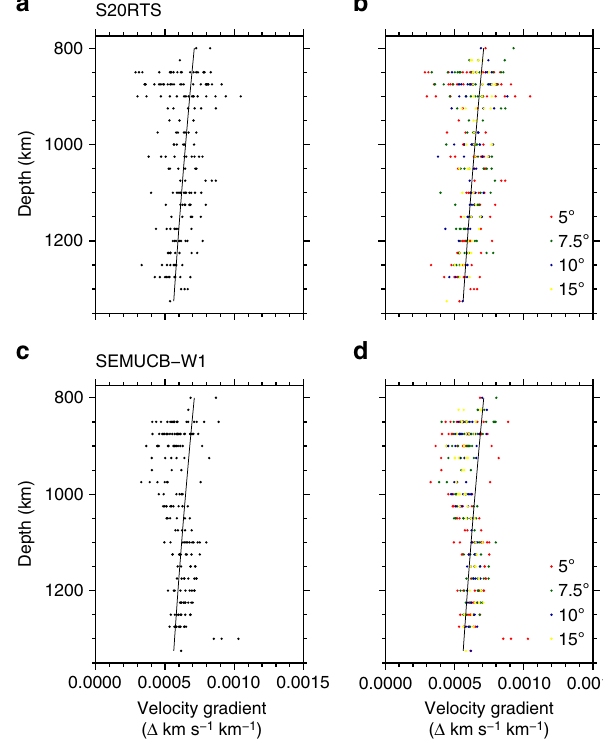
Fig. 8 Velocity gradients at the estimated depths of re fl ectors for S20RTS and SEMUCB-W1. a Combined bins, S20RTS 48 . b All bin sizes, S20RTS. c Combined bins, SEMUCB-W1 49 . d All bin sizes, SEMUCB-W1. Circles represented observed re fl ectors. Colours correspond to bin sizes as indicated in the key in b , d . Lines correspond to the velocity gradient from PREM 42 . Velocity gradients are calculated as the average in the bin, across a vertical distance of ± 25 km, centred on the re fl ector. The smallest cap sizes deviate furthest from the average velocity gradient. The gradient tends towards the global average as bin size increases, as